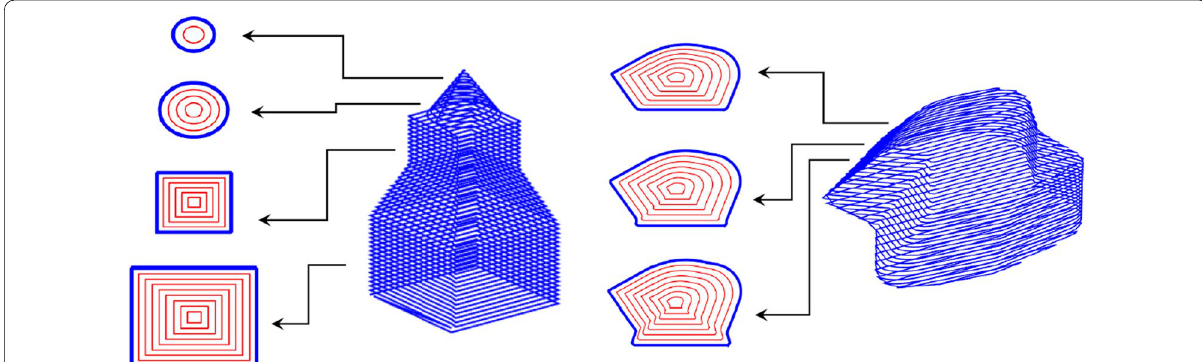
Fig. 8 Contour offset tool-paths generated by the proposed algorithm for different layers in both examples. The AM nozzle/print head traveled along with these offsets one by one until the entire layer was